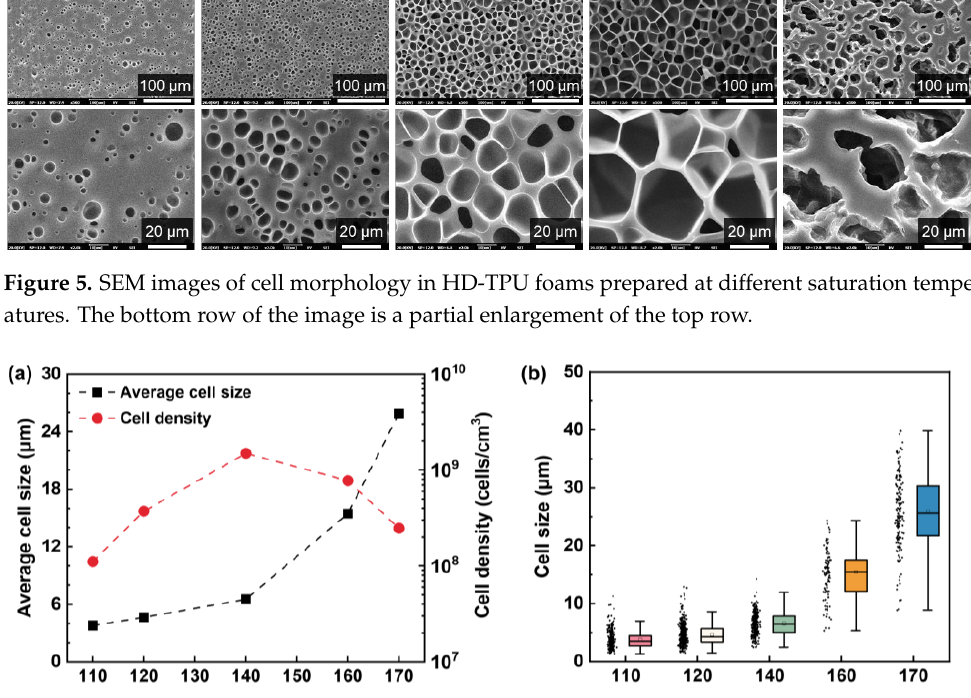
Figure 6. ( a ) Average cell size and cell density of HD-TPU foams as a function of saturation temper- ature. ( b ) Cell size distribution of HD-TPU foams as a function of saturation temperature.